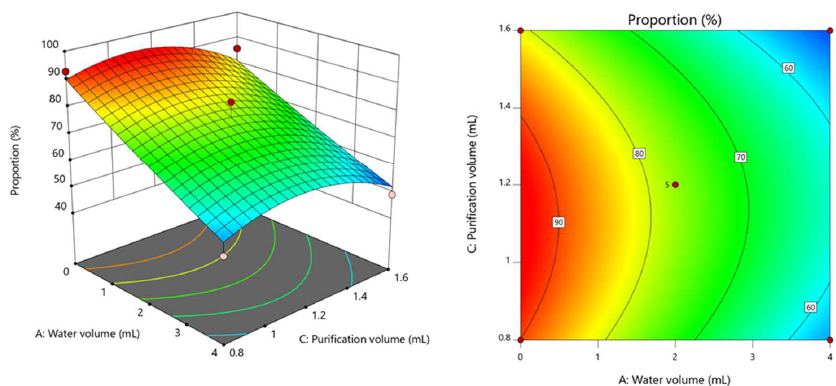
Figure 5. Response surface and contour diagram of R = f (A, C) with a 10 mL solvent volume.